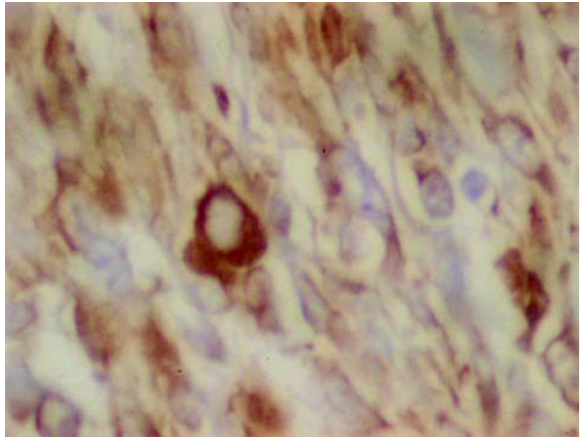
Figure 5 – Malignant fibrohistiocytoma of the penis. Immunohistochemical analysis for CD-68